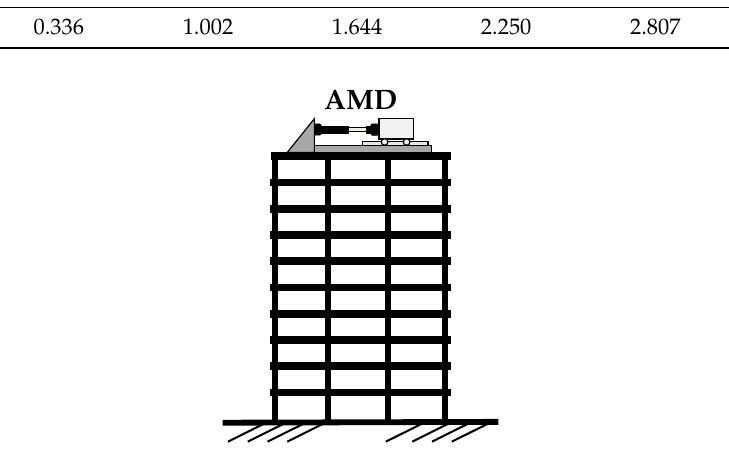
Figure 6. Illustration of the 10-story shear building with an active mass damper (AMD).